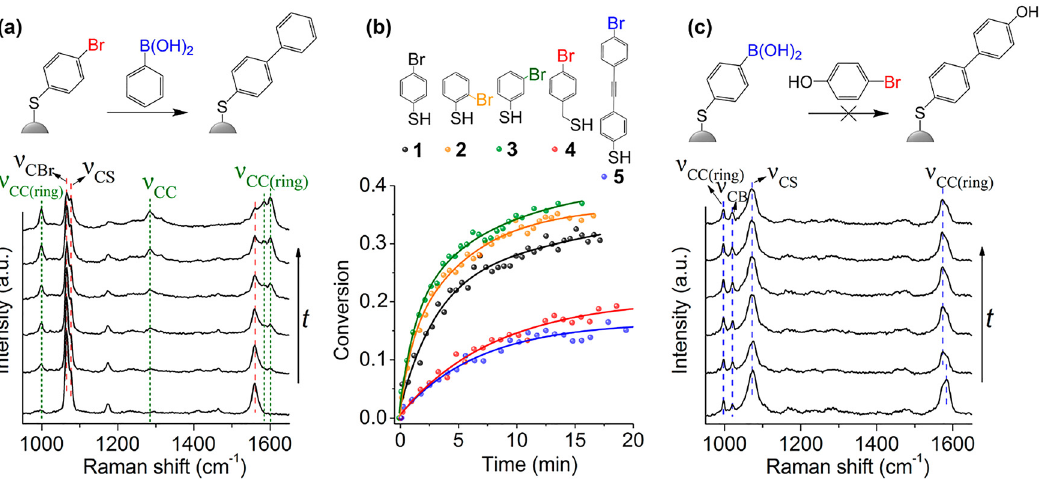
Figure 3: Suzuki-Miyaura reactions monitored by SERS. (a)SERspectraofSuzuki-Miyaurareactionsatdifferenttimepointson4-BTPcoatedAu-Pdstructures.(b)Kineticsofthereactionwithdifferent